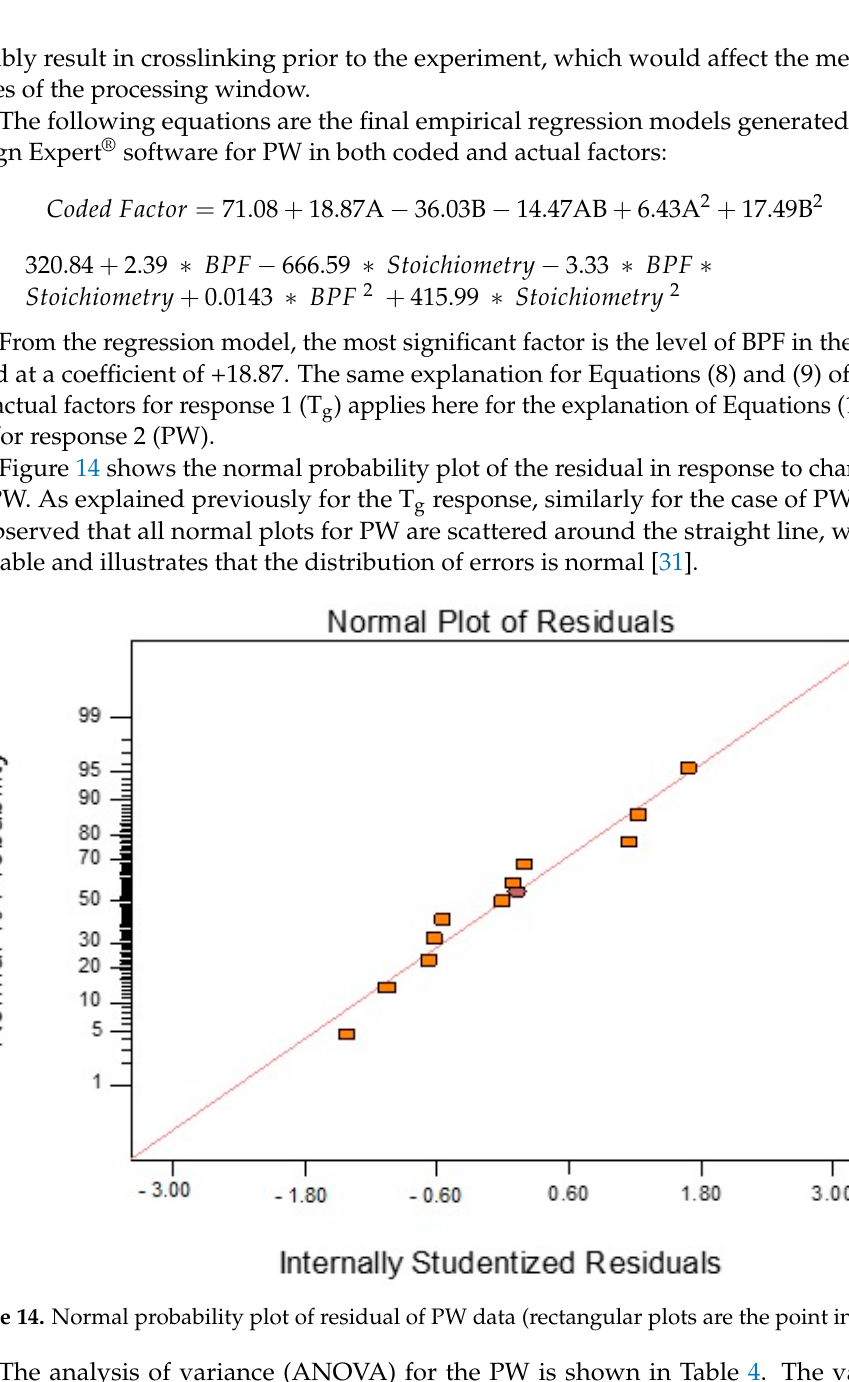
Table 4. ANOVA table for the surface response quadratic model (response: PW).